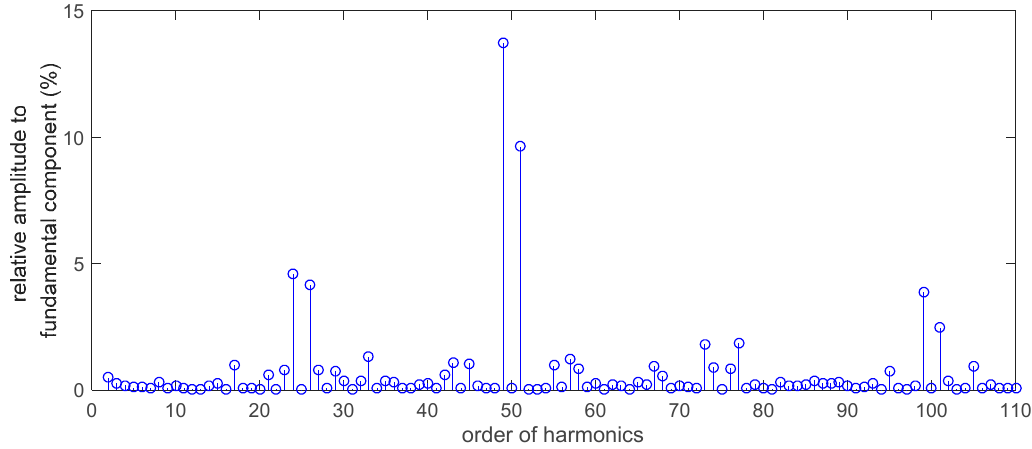
Figure 13. Relative amplitude to fundamental component of phase A’s voltage in 0.35–0.55 s.